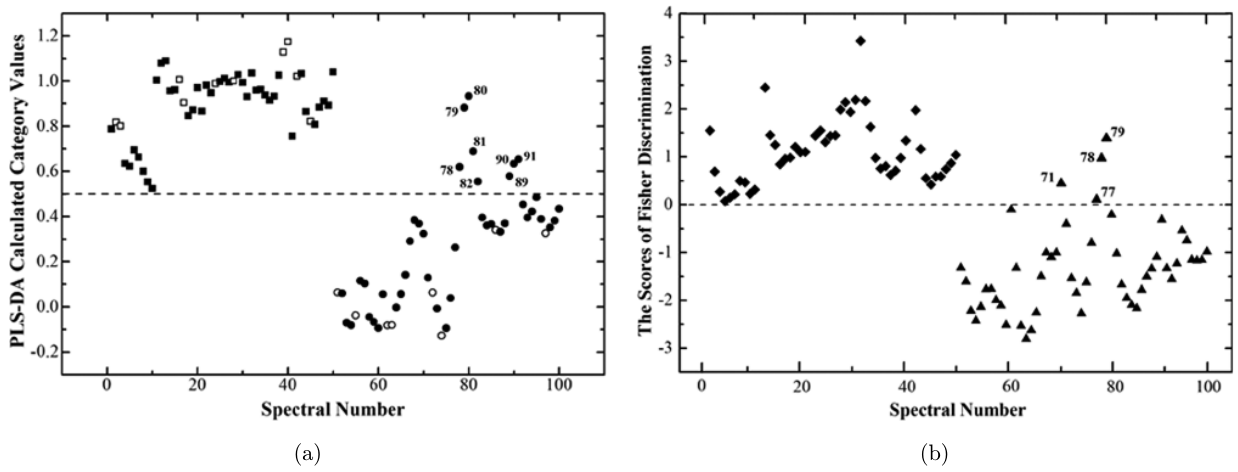
Fig. 4. (a) PLS-DA categorical values of training dataset and prediction matrix that were numbered from 1 to 100. Healthy ( ■ ) and OA ( (cid:3) ) cartilage spectra of training dataset were predicted for cross validation, healthy ( ¥ ) and OA ( (cid:4) ) cartilage spectra of prediction matrix were predicted by PLS-DA. (b) Scores calculated by PCA-FDA method. Healthy ( ¨ Þ and OA ( N ) cartilage spectra were sequenced with the same order in PLS-DA. Mis-assigned spectra in PLS-DA and PCA-FDA were marked with their sequence numbers and drawn above the dash lines.